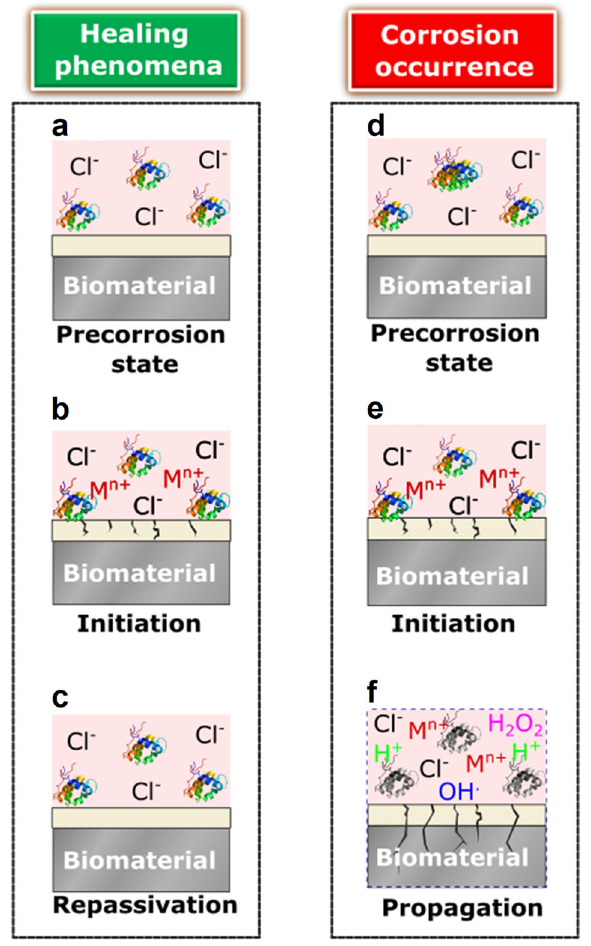
Fig. 1 Stages of corrosion and healing phenomena. Sketches a – c describe the stages of healing phenomena that occur in the materials capable of being healed, while sketches d – f describe the stages of corrosion that occur in the unhealed materials.